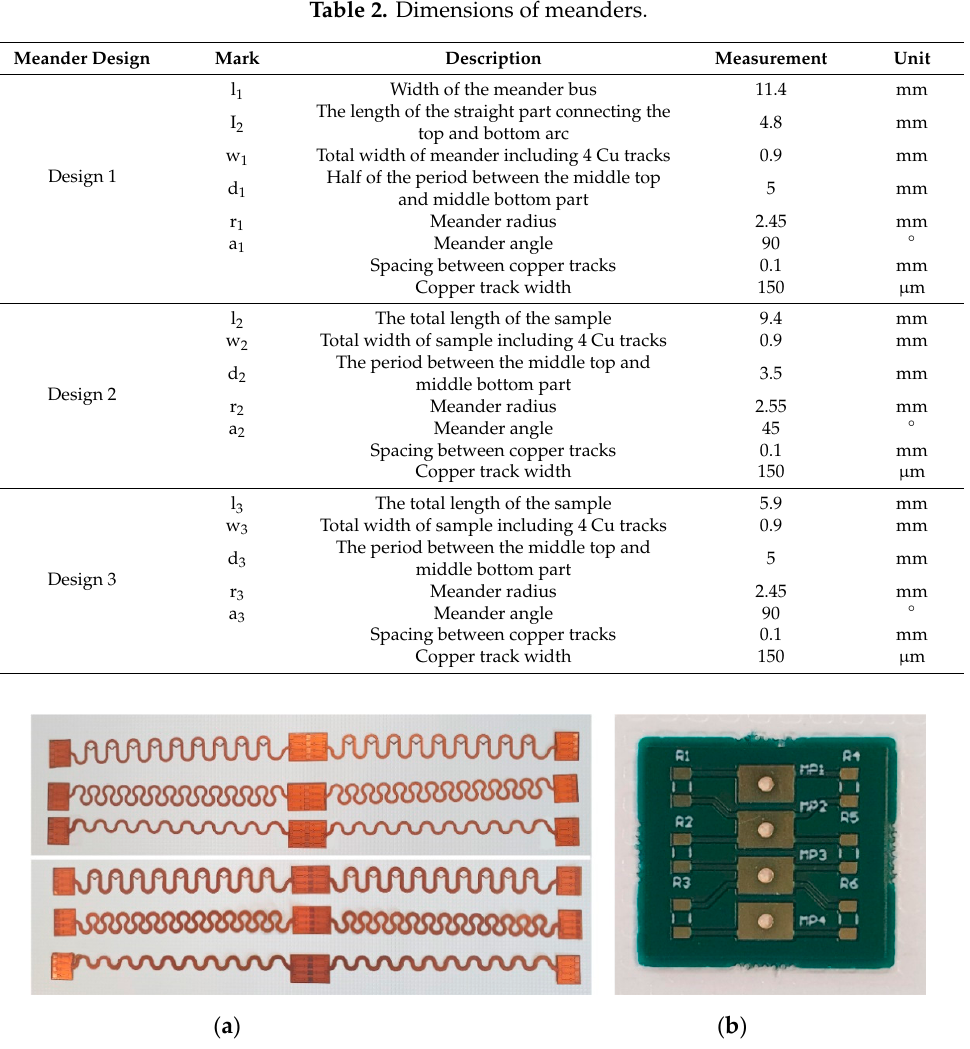
Table 3. Washing test procedure overview.